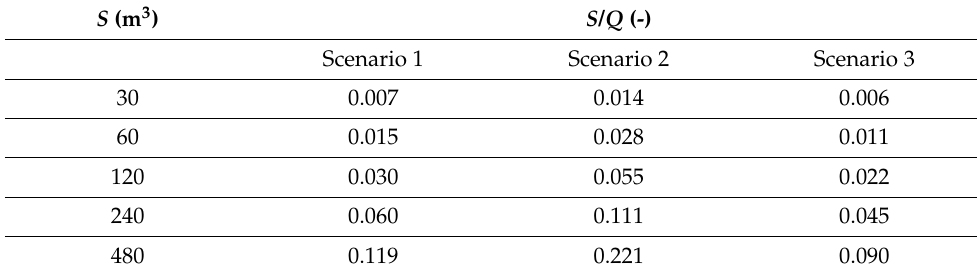
Table 1. Storage capacity of the system ( S ) and storage fraction ( S / Q ) in the three investigated scenarios. S (m 3